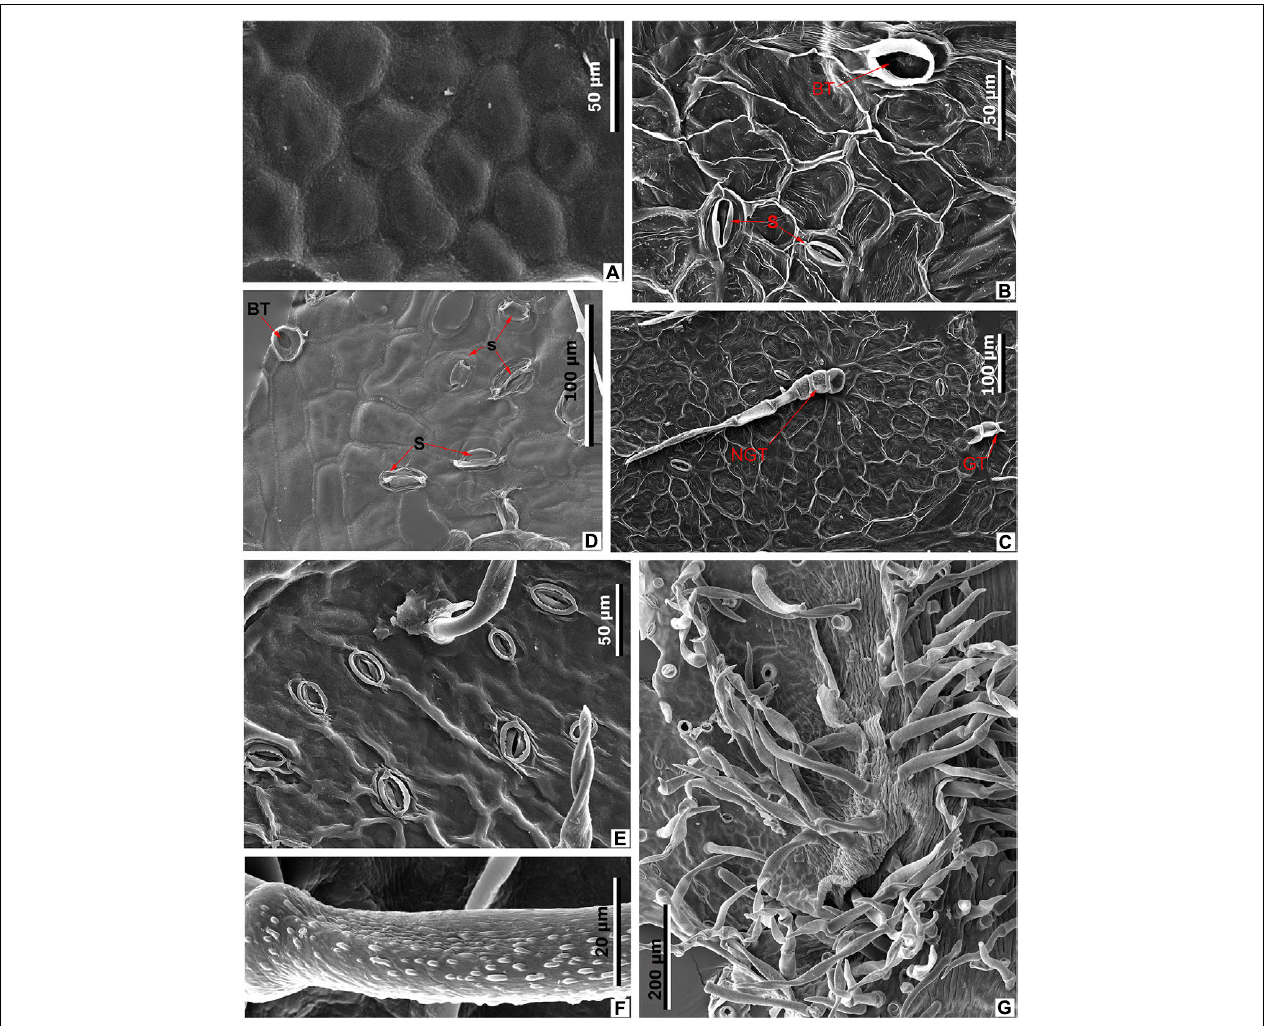
FIGURE 11 | Leaf epidermal characters of extant Meliosma , SEM. M. simplicifolia (Roxb.) Walp., XTBG (A,D–G) . (A) Ordinary cells on adaxial surface, internal view. (D) Stomata (S) and trichome base (BT) on abaxial surface, internal view. (E) Stomata and trichome base on abaxial surface, external view. (F) Trichome surface. (G) Leaf domatium. M. tenuis Maxim. SYS00085289 (B,C) . (B) Stomata (S) and trichome base (BT) on abaxial surface, internal view. (C) Abaxial surface with stomata, spinose multicellular non-glandular (NGT) and multicellular glandular (GT) trichomes, external